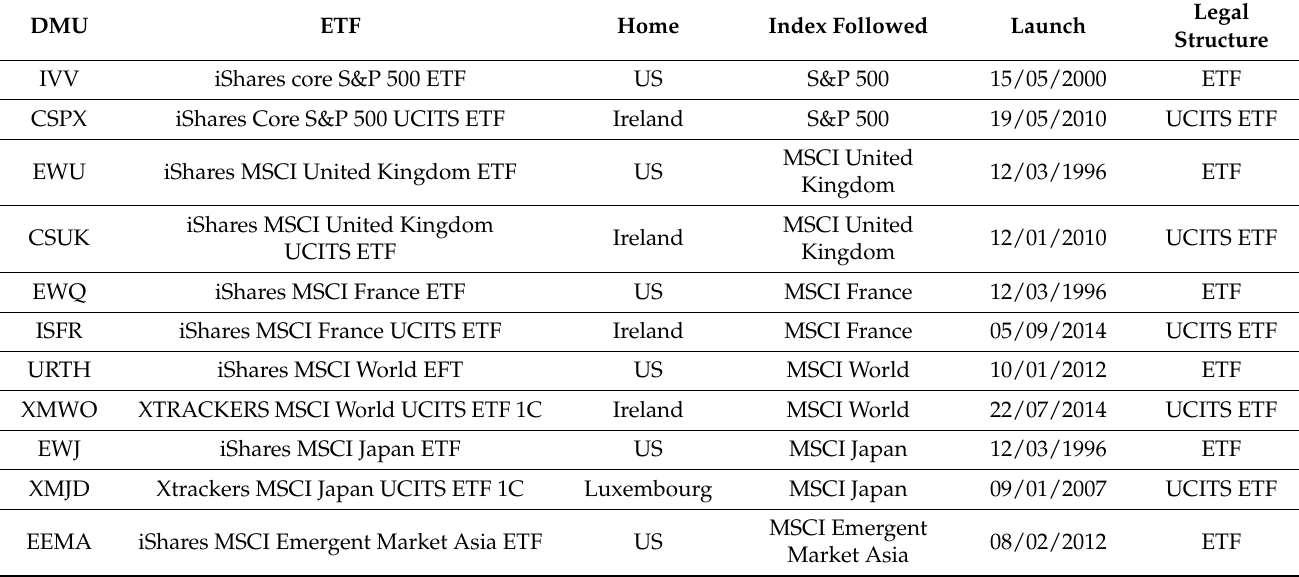
Table A1. Data on